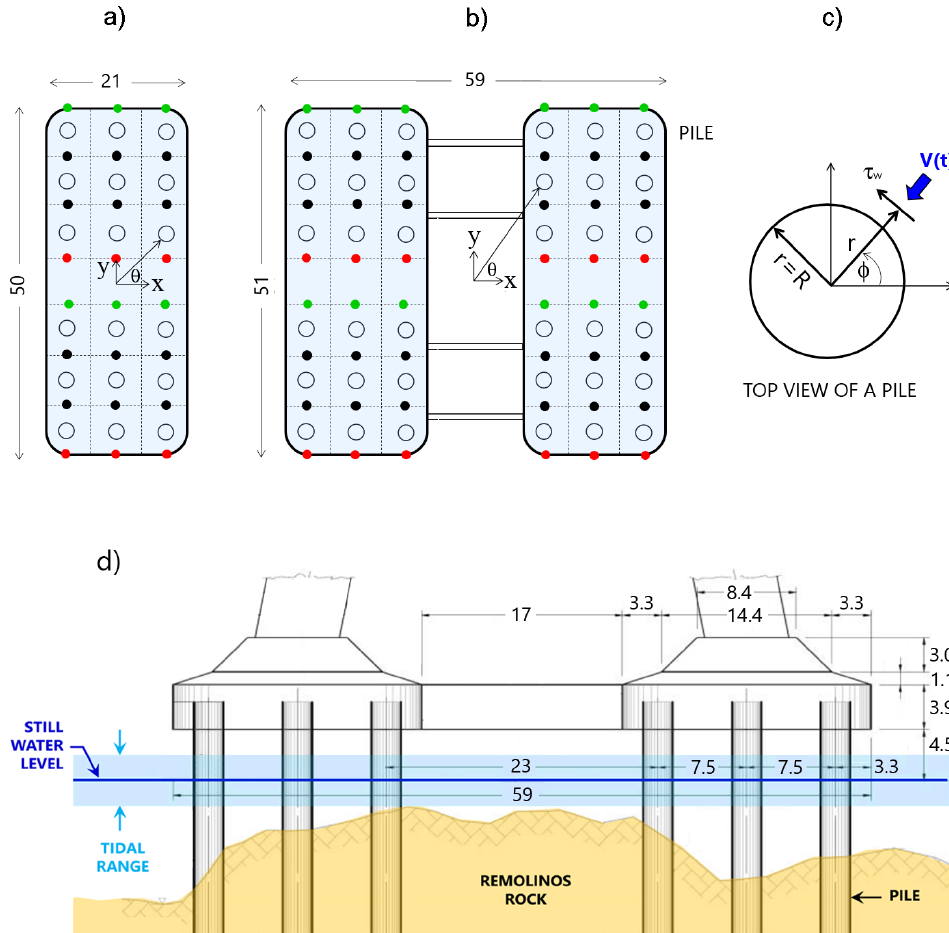
Figure 2. Top view geometry and dimensions, in m, of ( a ) North Tower (NT) and ( b ) Central Tower (CT) of Chacao bridge (adapted from [29]). NT is made up of two groups of piles, each having 9 cylindrical piles with diameters of D = 2.5 m. CT is a larger structure made up of four groups of piles, each formed by 9 piles of the same diameter. NT and CT occupy areas of 50 × 21 m 2 and 59 × 51 m 2 , respectively. The distance between neighbouring piles is s = 7.5 m, measured from their respective vertical axes. Dashed lines show profiles where speed and shear stress are estimated. Points in red (green): locations where the velocity V ( t ) was estimated for flood (ebb) tide scenario. Points in black: locations for estimating V ( t ) in both scenarios. ( c ) Definition of a reference frame for the estimation of the approximating flow velocities V ( t ) and the shear stress τ w acting around the piles. ( d ) Front view of CT